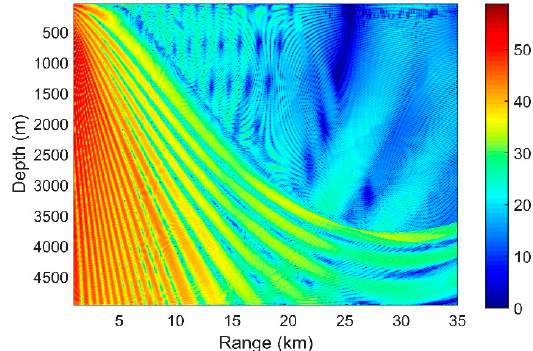
Figure 19. DT with different array locations.